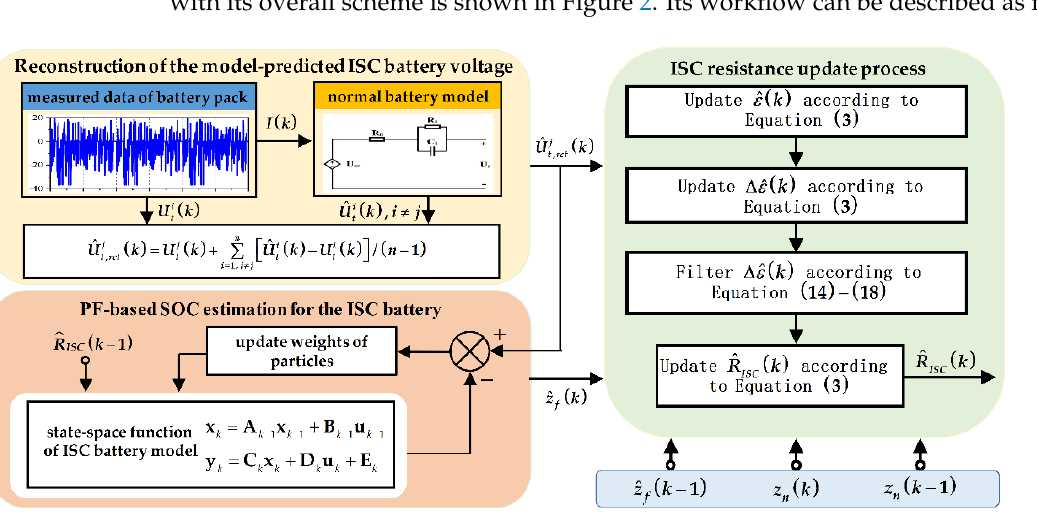
Figure 2. Overall scheme of the proposed online ISC resistance estimation method.